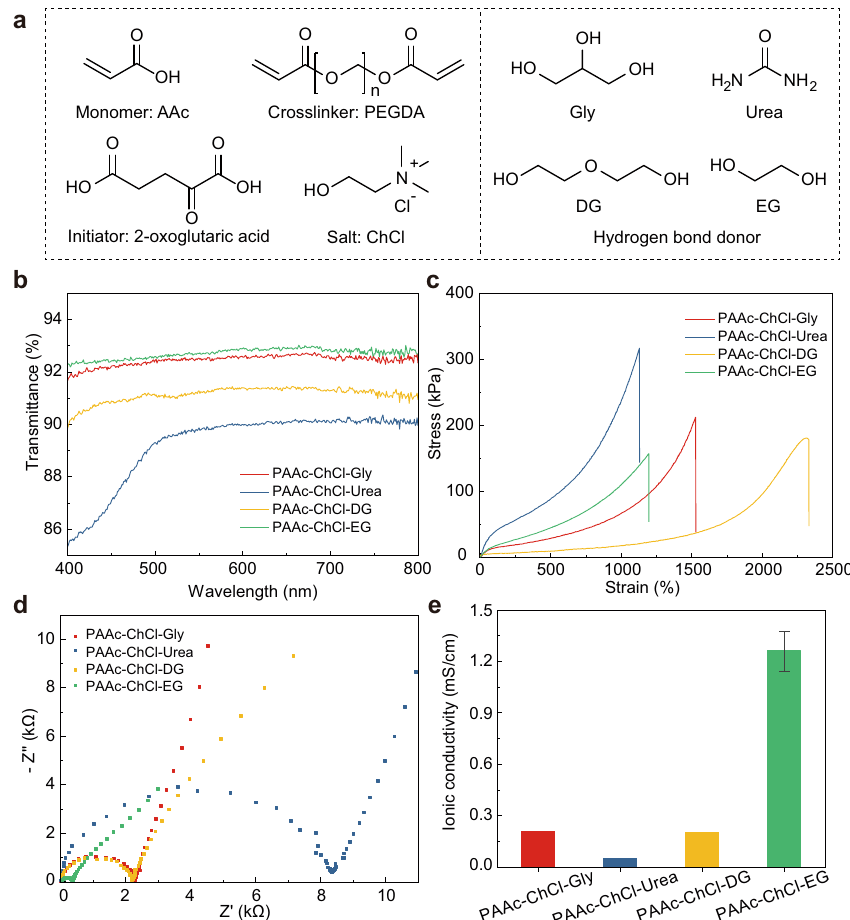
Fig. 1 Synthesis and optical, mechanical, and electrical properties of the PAAc – DES gels with different hydrogen bond donors. a Chemical structure of the monomer, crosslinker, initiator, salt, and four hydrogen bond donors. b UV – Vis spectrum of the four PAAc – DES gels. c Tensile stress – strain curves of the four PAAc – DES gels. d Nyquist plots and e ionic conductivity of the four PAAc – DES gels. Values in panel e represent the mean and standard deviation ( n = 3). The standard deviations for PAAc – ChCl – Gly, PAAc – ChCl – Urea, and PAAc – ChCl – DG gels are not shown in the graph because they are